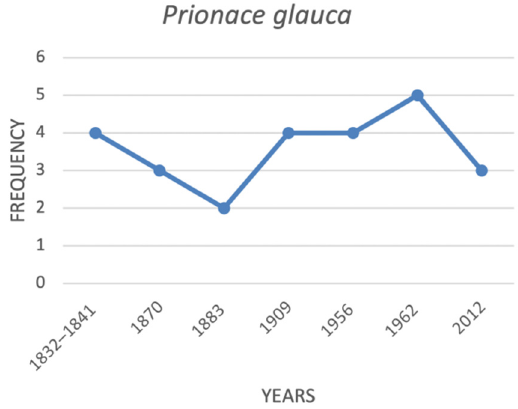
Figure 9. Temporal trend of Prionace glauca .